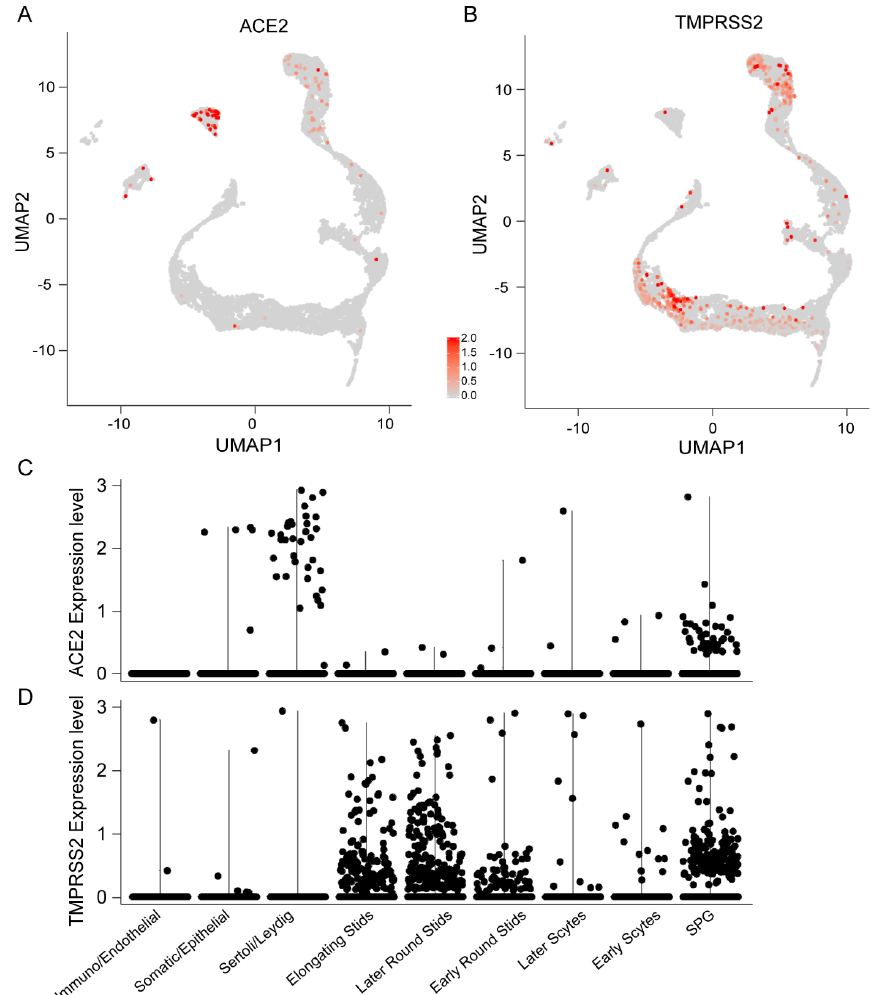
Figure 2. Angiotensin-converting enzyme 2 (ACE2) expression pattern in adult human testes. ( A ) Per-cell expression level of ACE2 of human testicular cells visualized on the UMAP plot. ( B ) UMAP plot of transmembrane serine protease 2 (TMPRSS2) expression across all cell clusters. ( C ) Violin plots of ACE2 expression in all identified cell types. ( D ) Violin plots of TMPRSS2 expression across all cell types. SPG—spermatogonia.